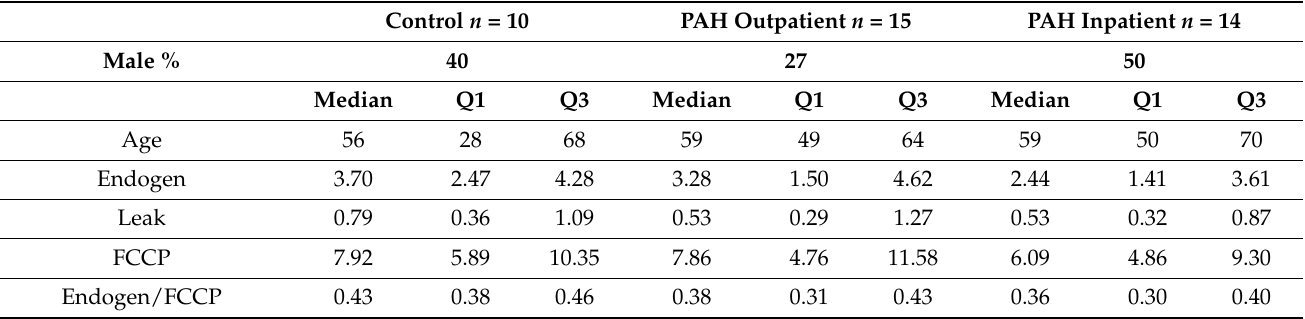
Table 1. Patients’ characteristics. No statistically significant differences were found between the